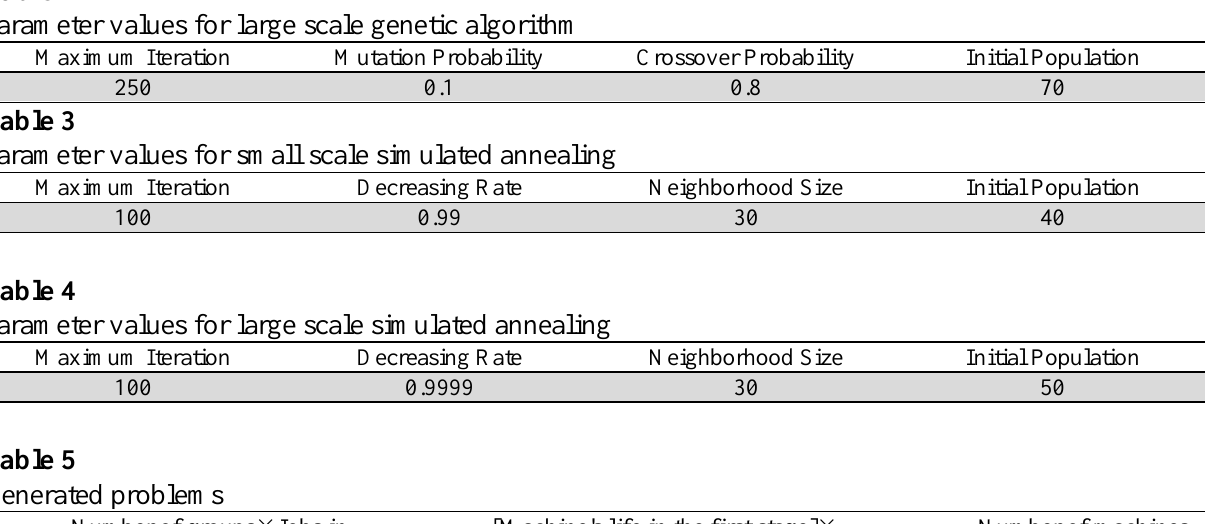
Generated problems Number of groups  Jobs